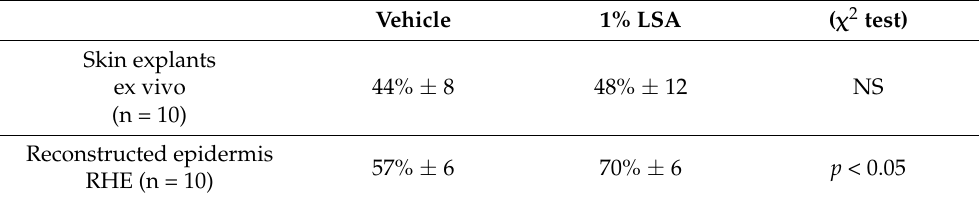
Table 2. Topical chemical aggression in vitro (RHE), but not ex vivo (explants), induces an increase in TJ-derived fusions in the nascent SC. TJ-derived fusions within the apical-lateral contacts of corneo- cytes were counted in the first two layers of SC after 24 h topical treatment with beta-lipohydroxy salicylic acid (LSA). At least 100 apical-lateral contacts were examined at high magnification on several ultrafine sections of each specimen. NS = not